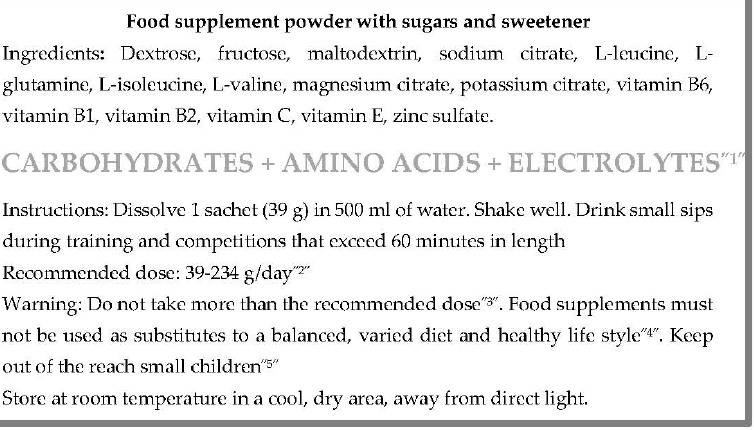
Figure 3. An example of the back of a supplement label. Adapted from a commercial product.